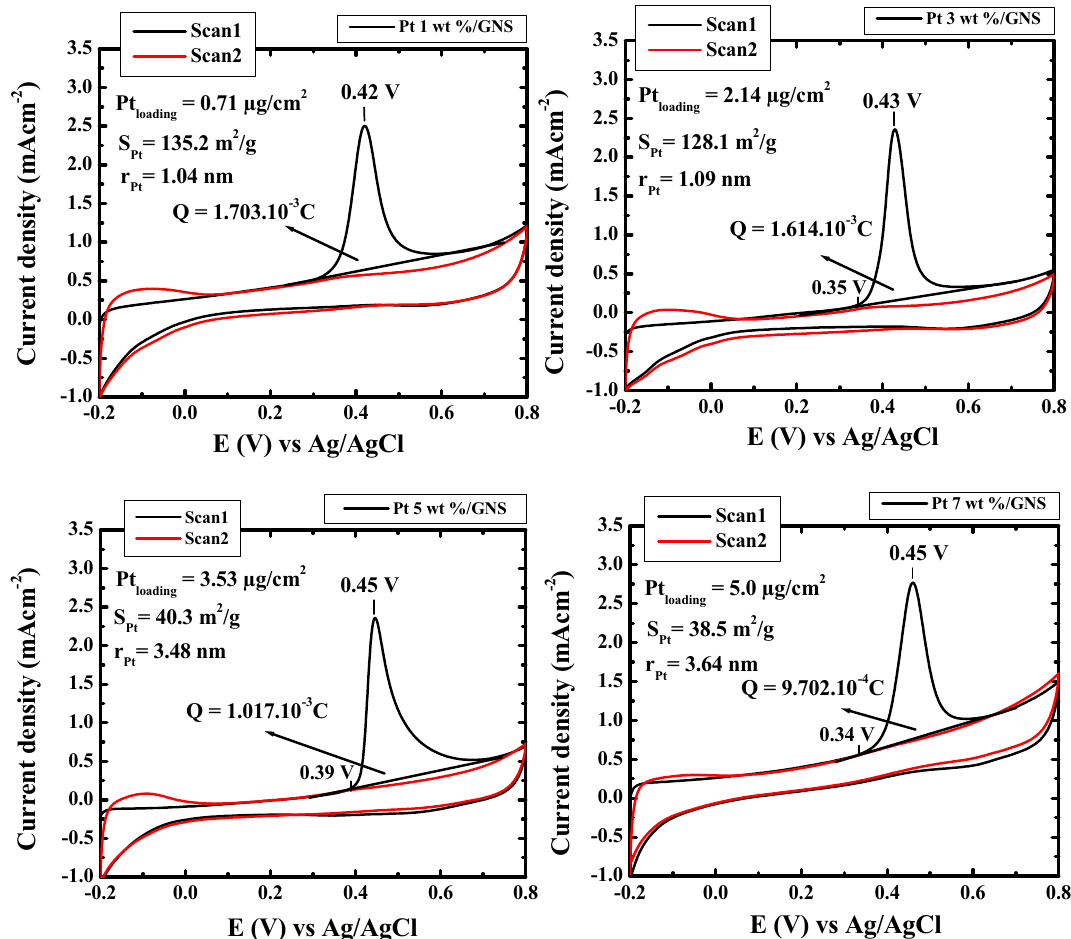
Figure 12. CO stripping voltammogram of 1–7 wt.% Pt/GNS, respectively on a rotating disk electrode (RDE) measured in 0.1 mol dm −3 HClO 4 at 60 °C. Rotating speed 500 rpm and scan rate of 10 mVs −1 between—0.20 and 0.8 vs